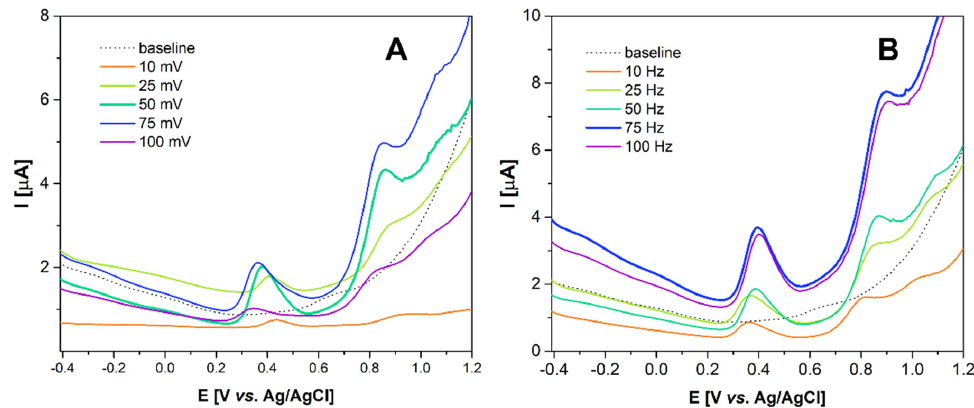
Figure 5. ( A ) SWV voltammograms of 0.1 mM MORPH in BRBS at pH 8, for pulse amplitude in range 10–100 mV and ( B ) SWV voltammograms for 0.1 mM MORPH in BRBS at pH 8, frequency range 10–100 mV.